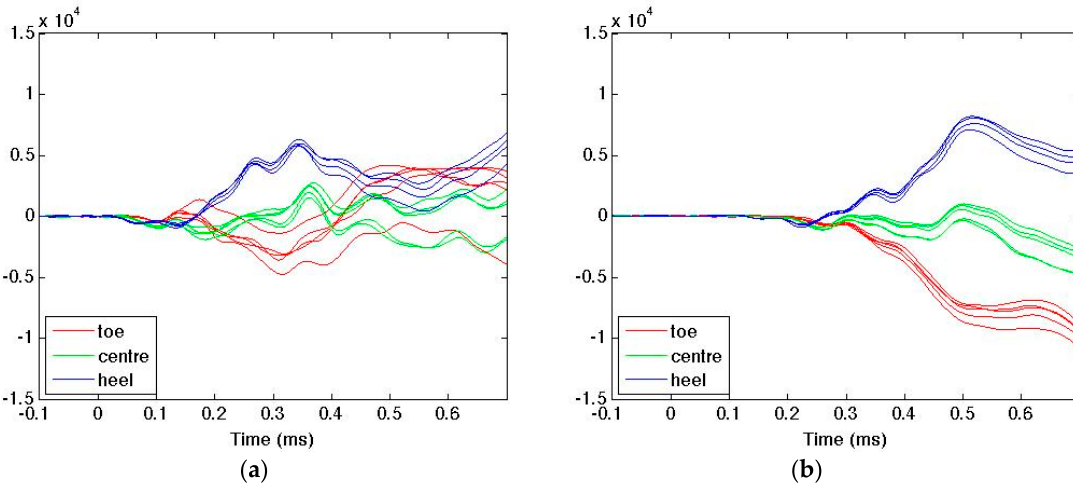
Figure 3. Torsional strain signals measured at the tip ( a ) and grip ( b ) for five trials at each of the three impact locations at 34 m·s − 1 .